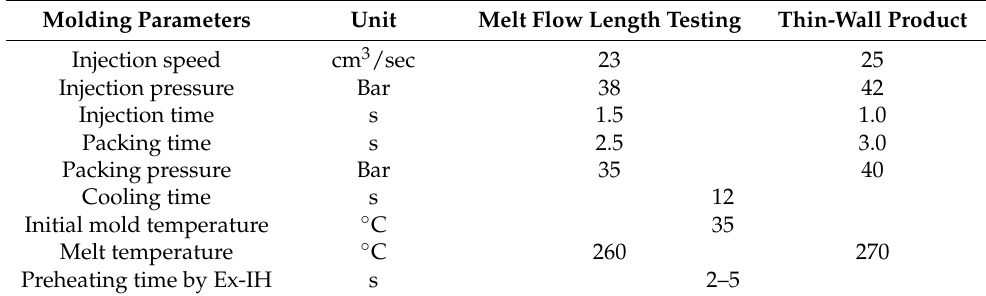
Figure 8. The cavity plate for ( a ) the melt flow length model, ( b ) thin-wall product, and ( c ) the core plate with the gap for assembling the heating insert. Table 2. The molding parameters for the product of melt flow length testing and thin-wall